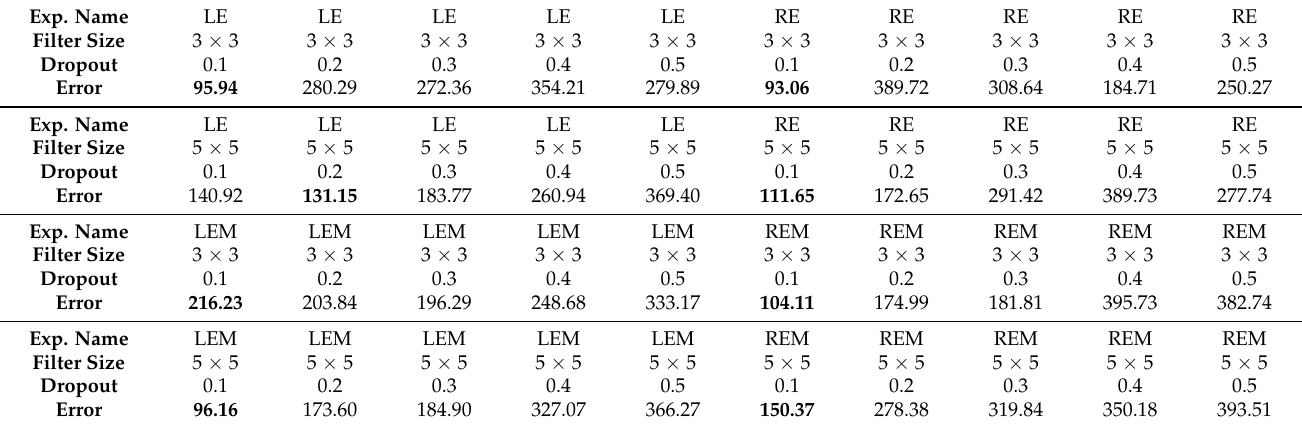
Table 5. Results of LE and RE with and without a mask (learning rate =